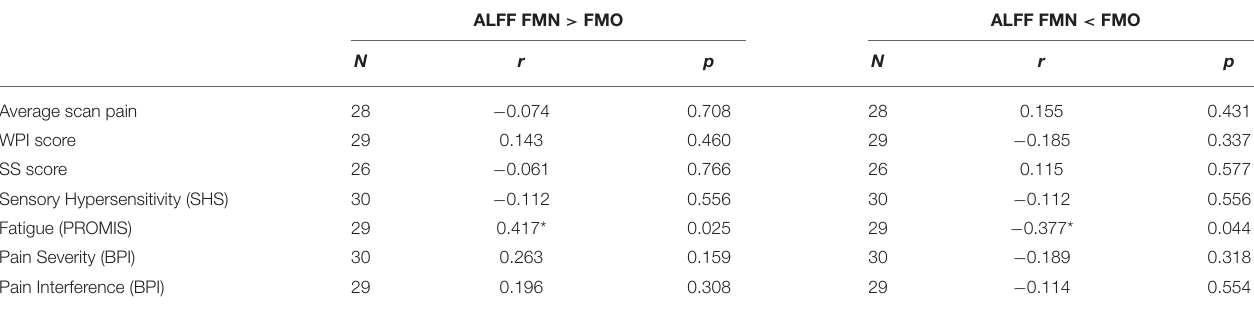
TABLE 2 | Pearson correlations between region extracted Mean ALFF (0.01–0.198Hz) and symptom measures across non-opioid FM patients ( N = 15) and opioid FM patients ( N = 15). ALFF FMN > FMO ALFF FMN <